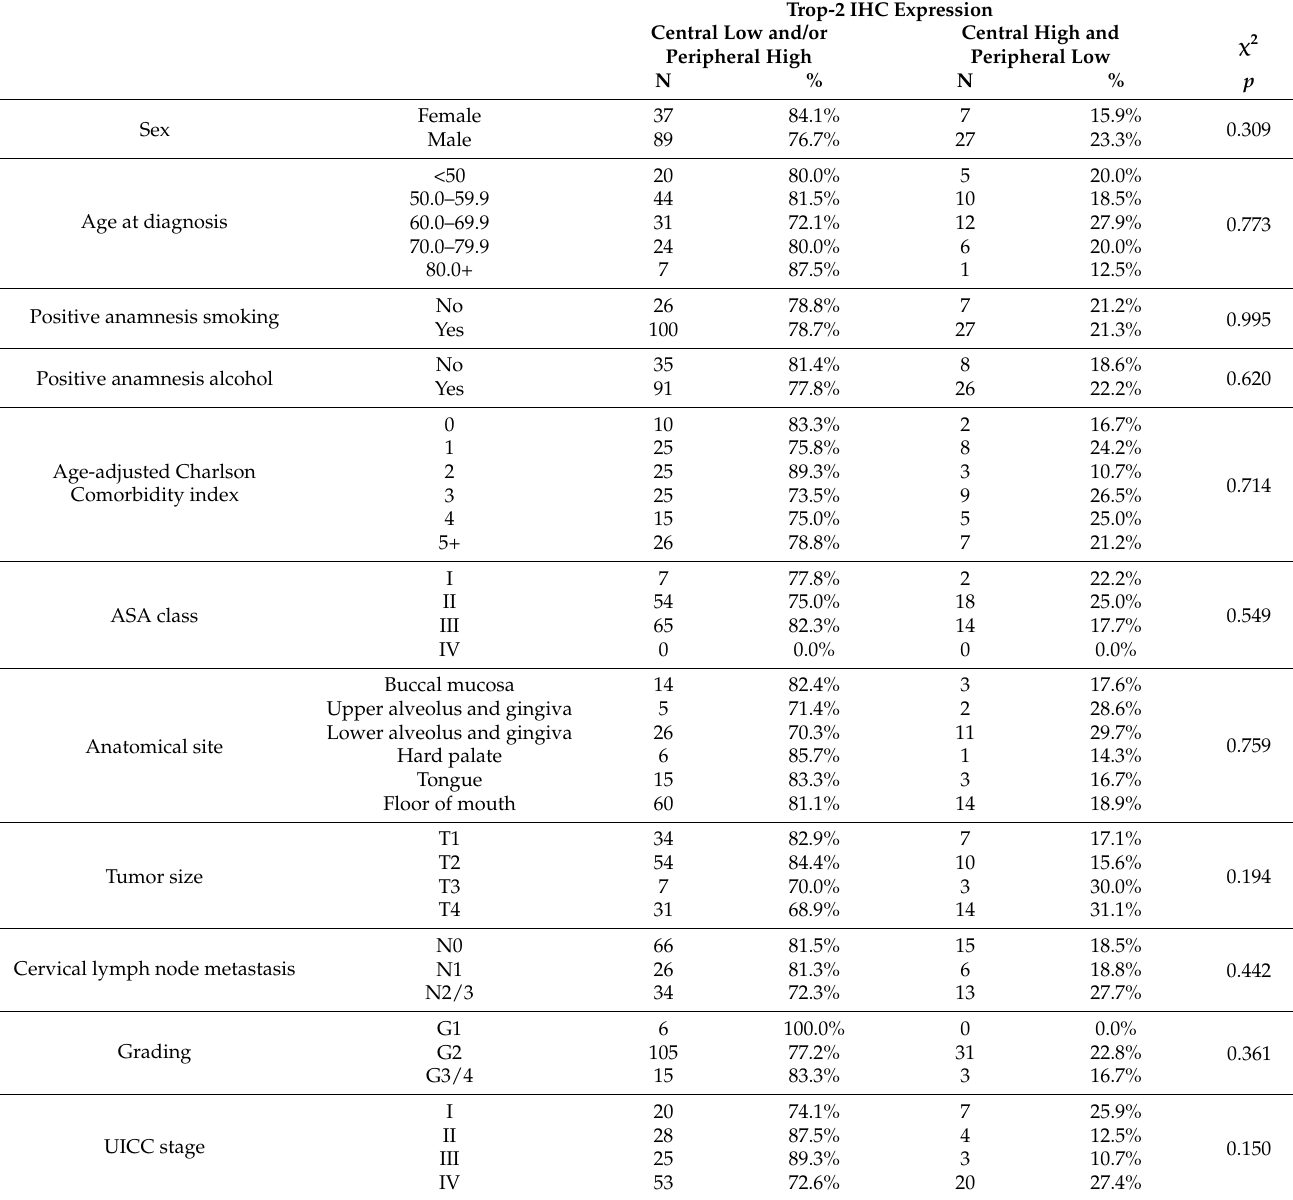
Table 1. Patients’ clinicopathological characteristics according to Trop-2 expression in the central and peripheral tumor in the analyzed TMA cohort of n = 160 OSCC patients, UICC 7th edition. Trop-2 IHC Expression Central Low